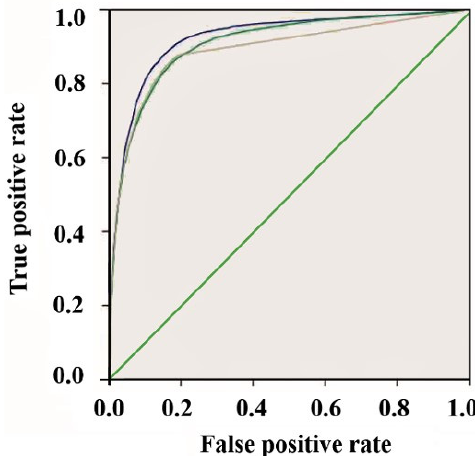
Figure 6. The accuracy of Data fusion methodology (blue curve) was compared to Fimo (green curve) and Matrix scan (yellow curve) using ROC curves for the ARF39 binding sites. Higher curve (close to the top left corner) represents the ROC curve of our method corresponding to the model with better ARF-binding sites prediction quality.